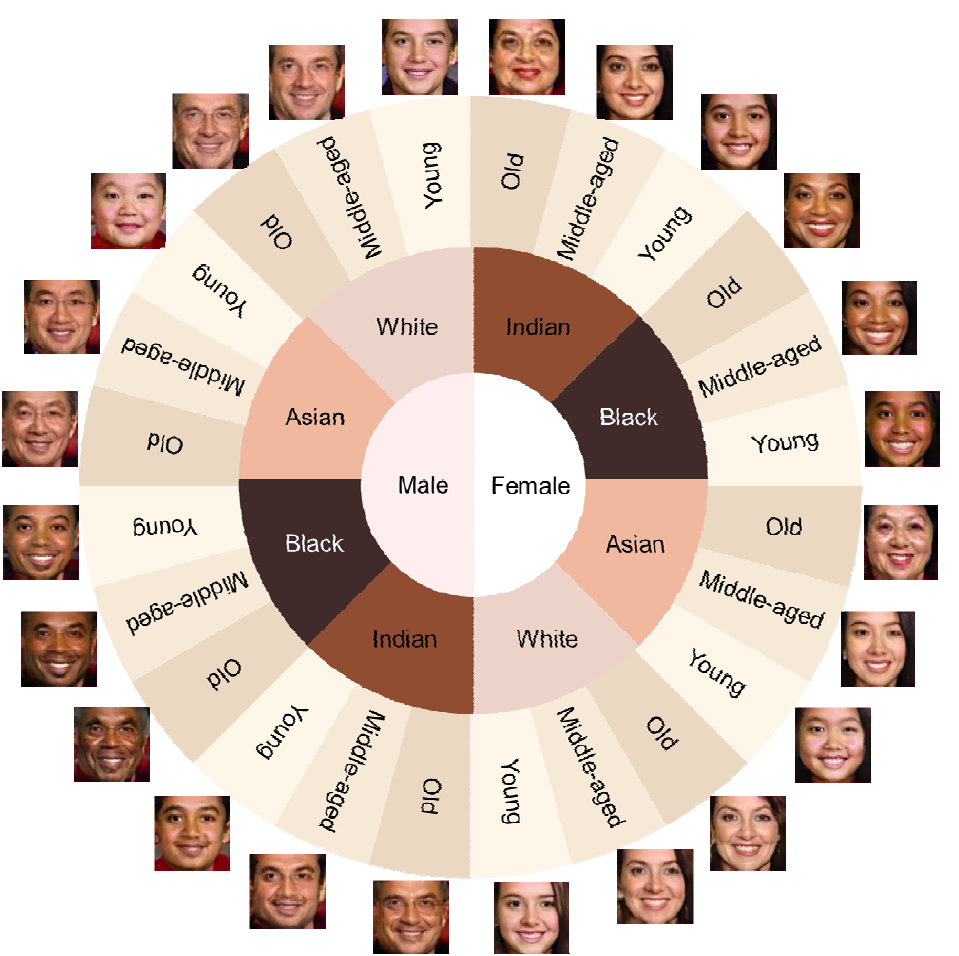
Figure 1. Teaser image of our framework, which produces 24 different portrait images by varying three group attributes: sex, race, and age. Sex had two values: male and female; race had four: White, Asian, Black, and Indian; age had three: young, middle-aged, and